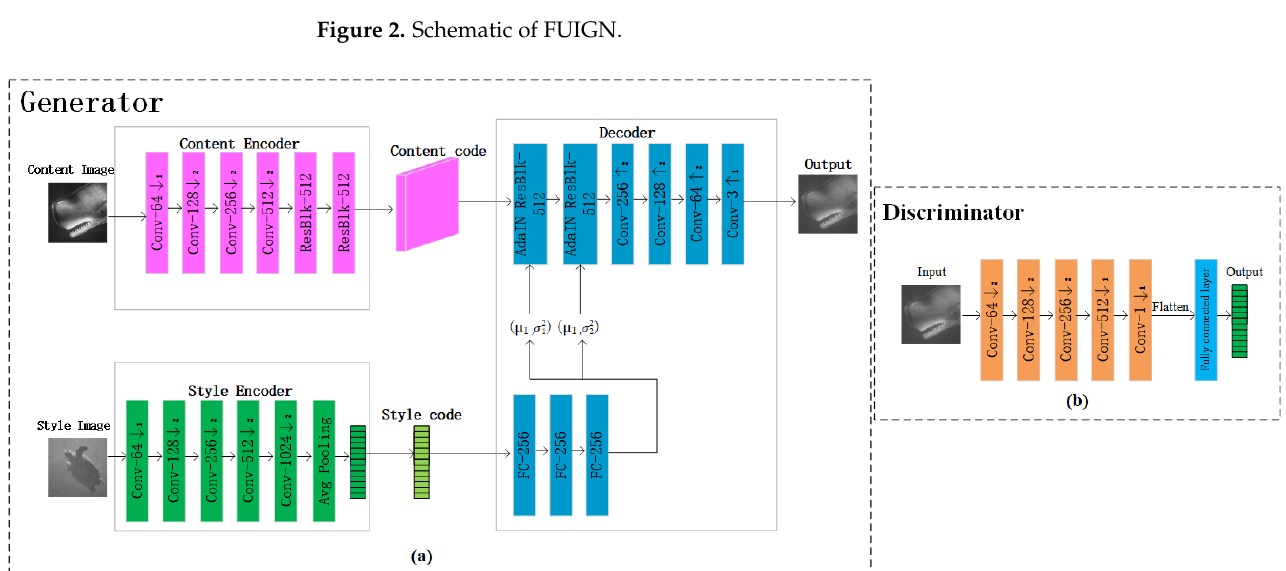
Figure 3. Generator and discriminator of FUIGN. ( a ) architecture of the generator of FUIGN; ( b ) architecture of the discriminator of FUIGN;